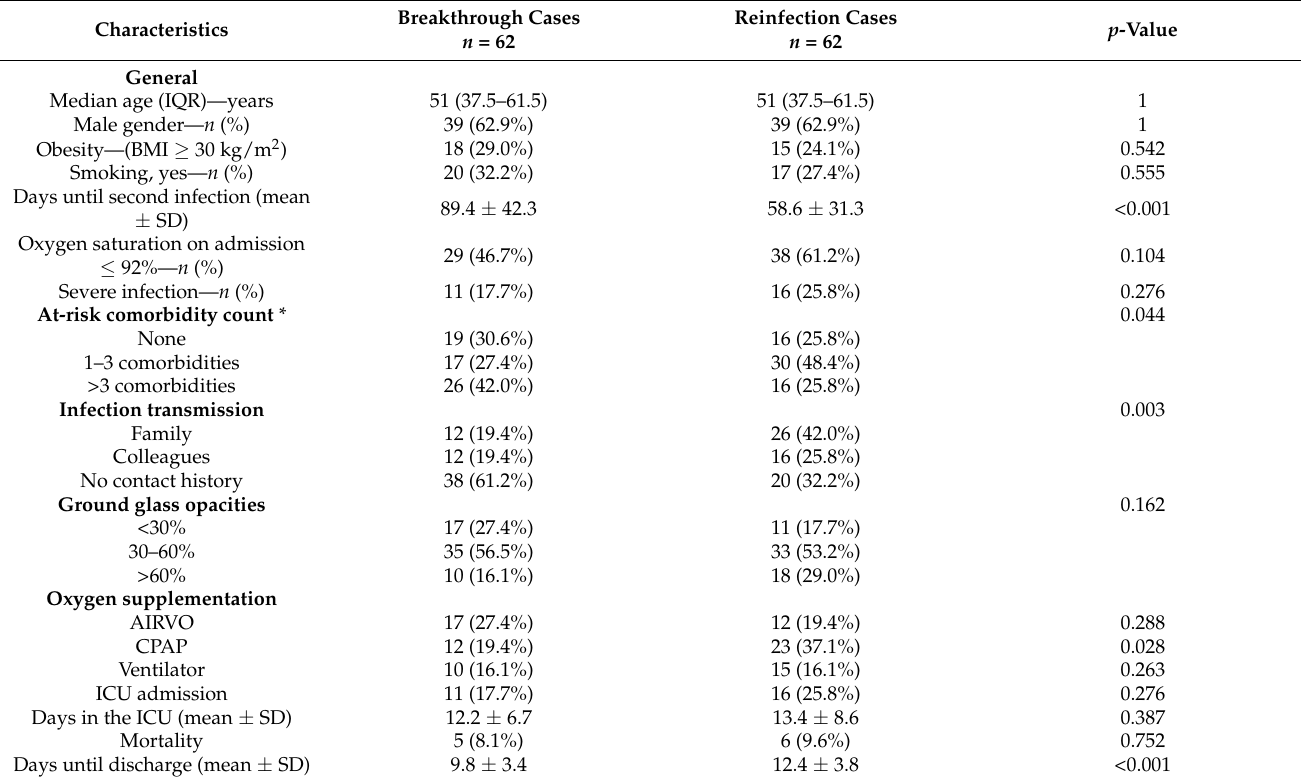
Table 1. Main characteristics of the cases and controls. Case-matched by age and